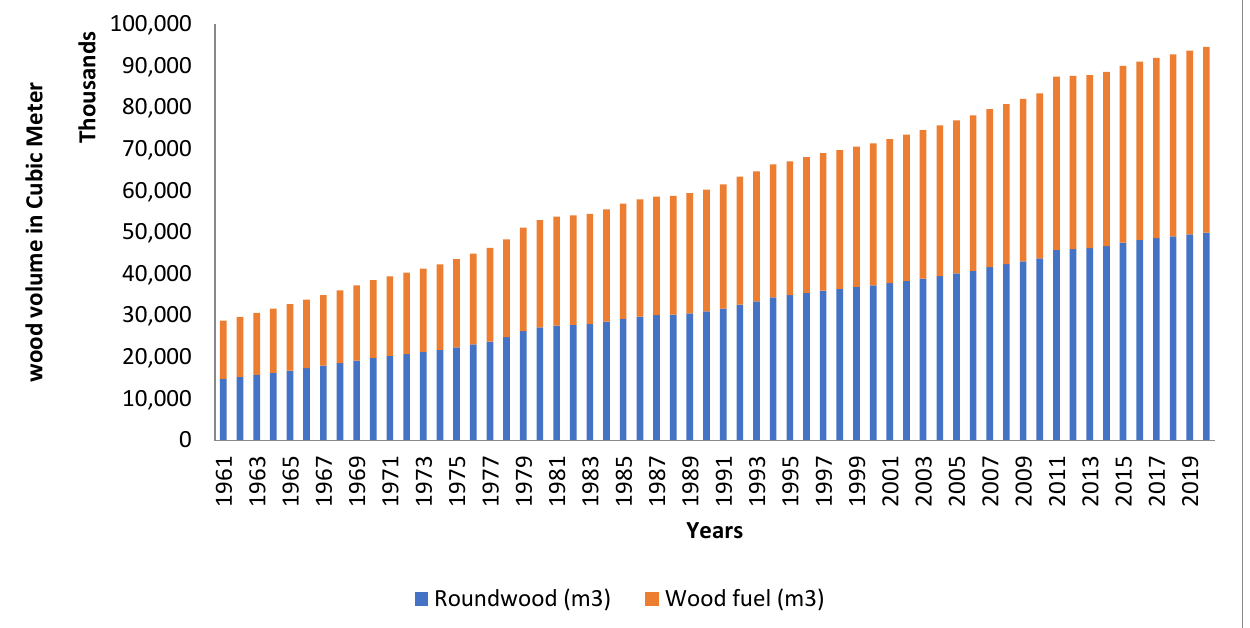
Figure 2. Total roundwood and total wood fuel production (1961 to 2020), own analysis.